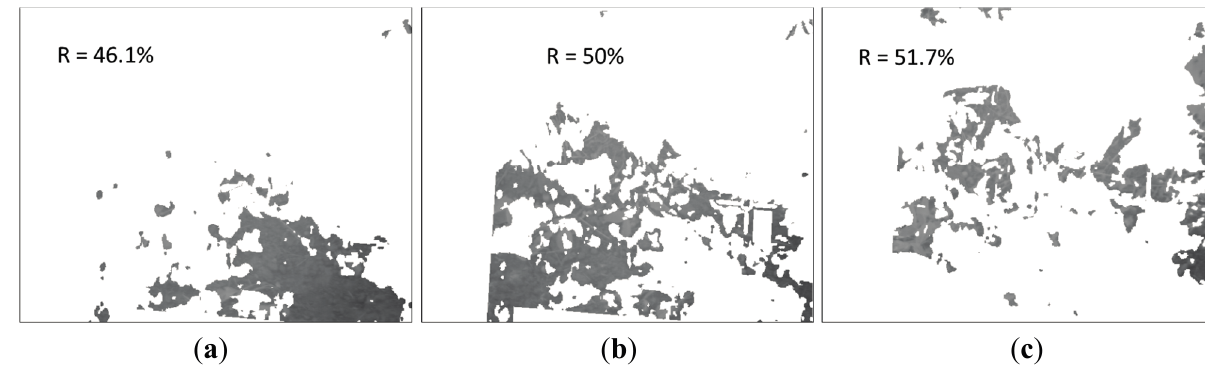
Figure 21. Delimited areas and mean reflectance percentages on the normalised SWIR image. ( a ) First cluster; ( b ) Second cluster; ( c ) Third